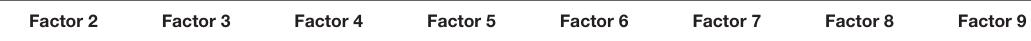
TABLE 3 | Item factor loading for CERQ factors (model 2), n =